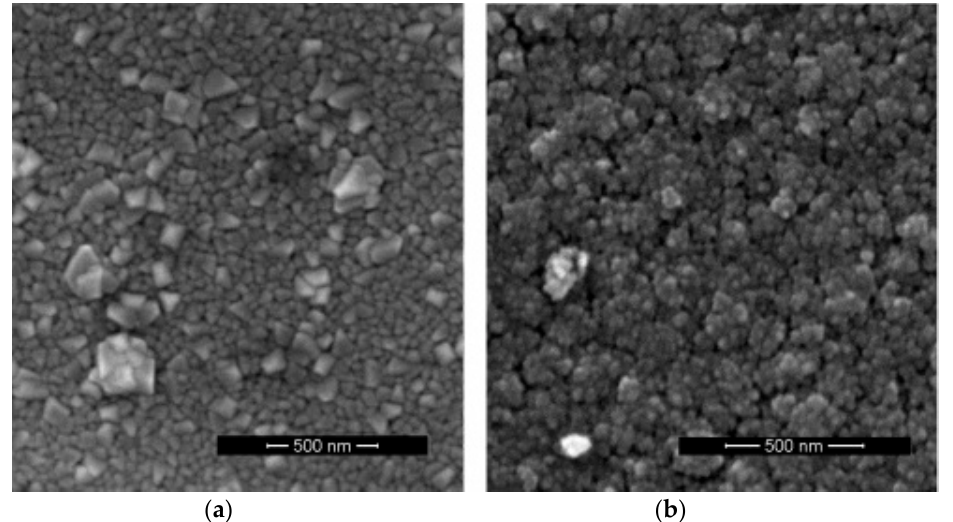
Figure 3. SEM images of the surfaces of Pd/WO 3 bilayer thin films. The WO 3 layer is deposited at 600 °C in 150 mTorr O 2 . ( a ) Surface. ( b ) Section.